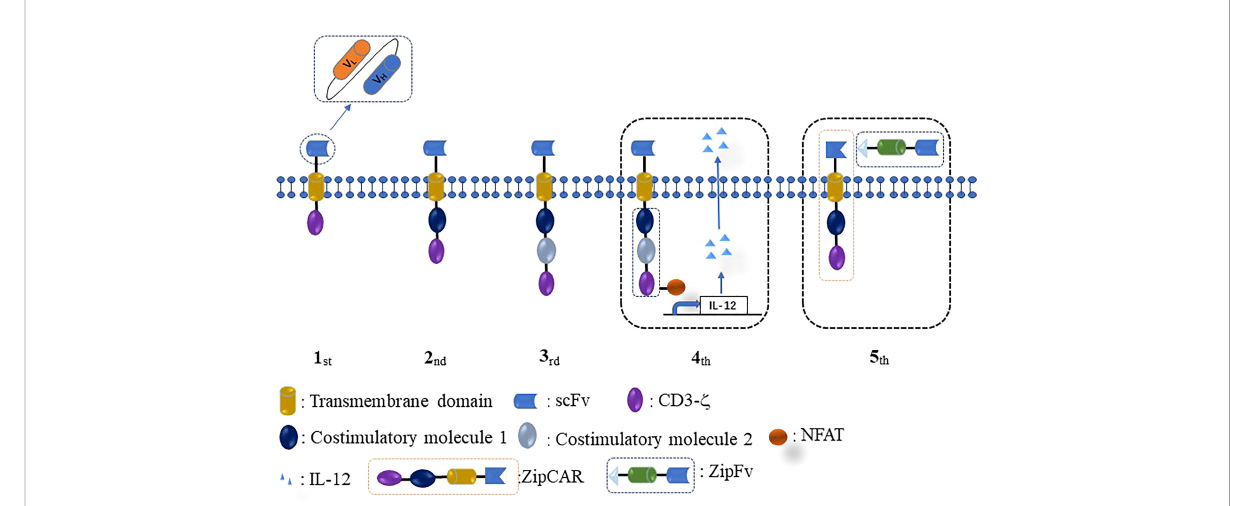
FIGURE 1 Different generations of CAR design. The intracellular domain of the fi rst CAR only consists of one signaling domain (CD3 z ). The second CAR adds one co-stimulatory molecule (CD28/4-1BB/OX40/ICOS) to the intracellular domain of the fi rst CAR. The third CAR contains two costimulatory molecules in the intracellular domain. The fourth CAR is designed by adding NFAT or suicide gene based on the second or third CAR. The fi fth CAR uses a “ third-party ” intermediate system to separate the antigen-binding domain of CAR from the T-cell signaling